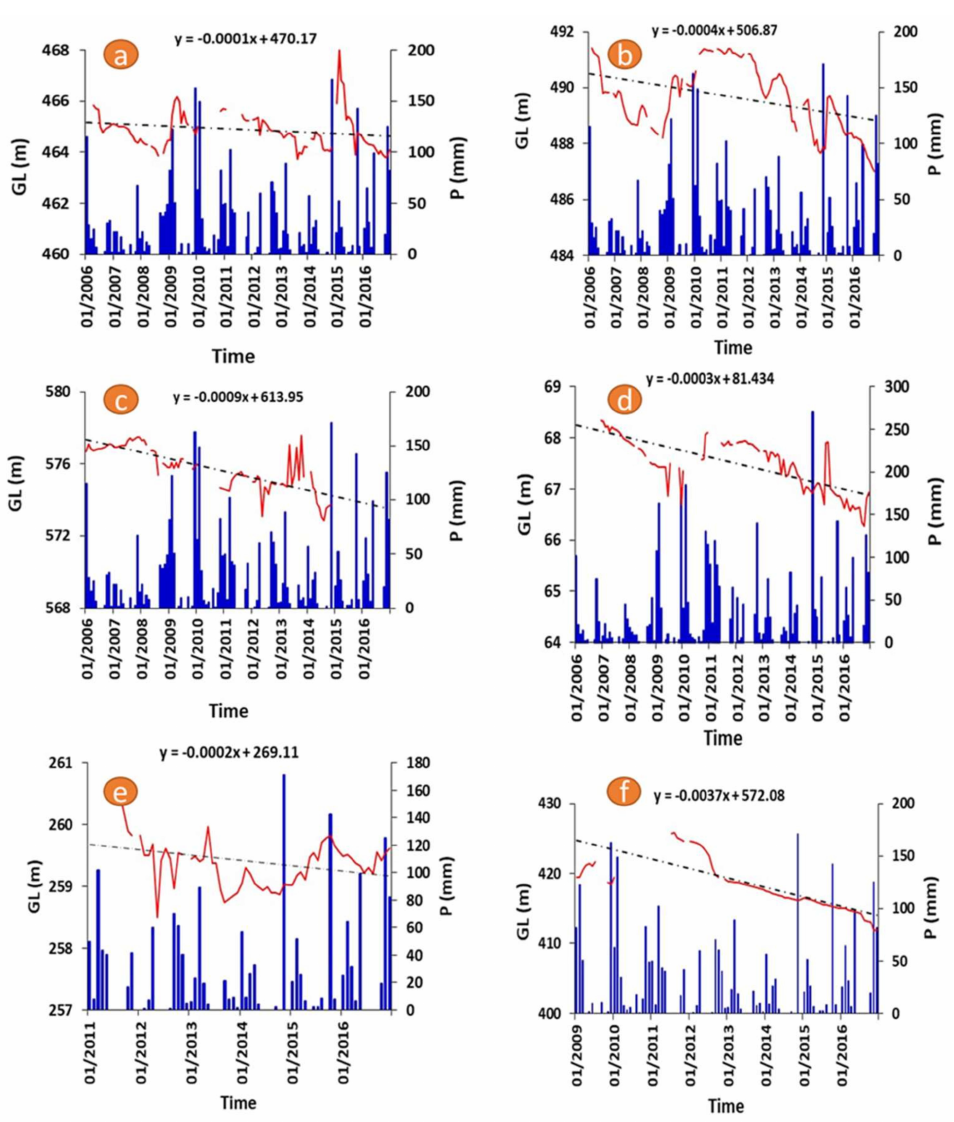
Figure 8. Groundwater levels’ evolution between 2006 and 2016 (( a – f ) are piezometric monitoring points for the locations, see Figure 2). GL: groundwater level, P: